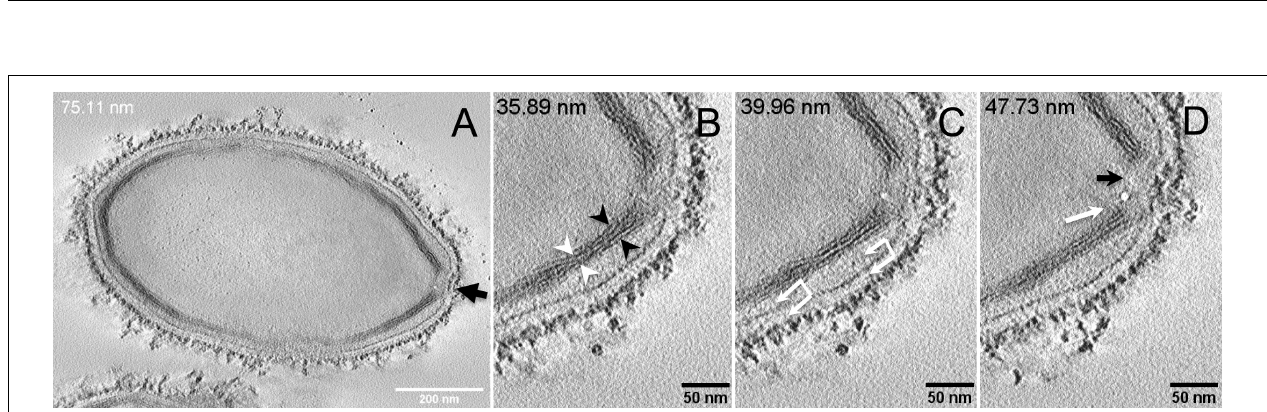
FIGURE 3 | Electron tomography of P. massiliensis particle from Movie 4 . (A) Single plane in the tomogram from Movie 4 showing a whole Pandoravirus particle and its ostiole located at one apex (arrow). (B) . The inner-most layer is composed of two thick tubules well separated (black arrowheads) or contacting each other (white arrowheads). (C,D) Thin fibers (arrows) originating from the inner-most tubular thick layer projecting toward the peripheral sugars (white arrows, C ), toward the inner core of the particle (white arrow, D ) or at the level of the ostiole (black arrow, D ).